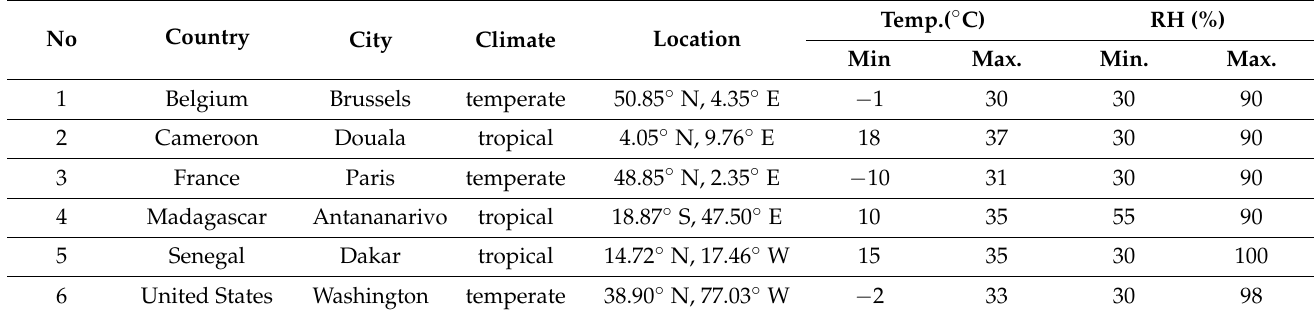
Table 3. Information regarding the six selected representative